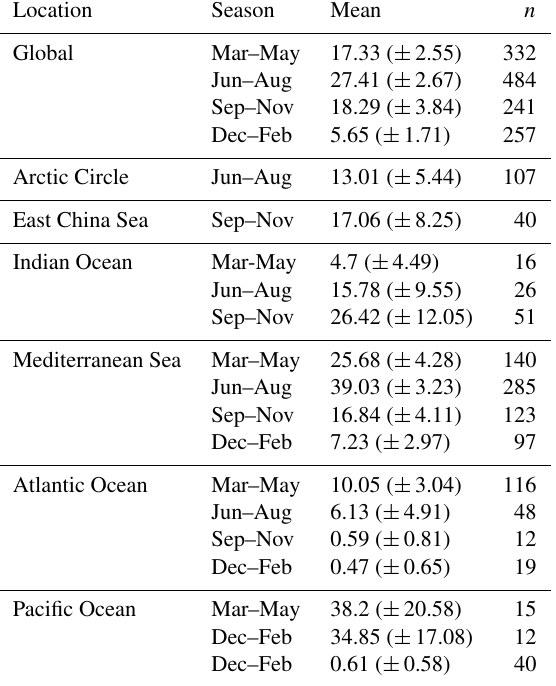
Table 4. Global HOLP index.